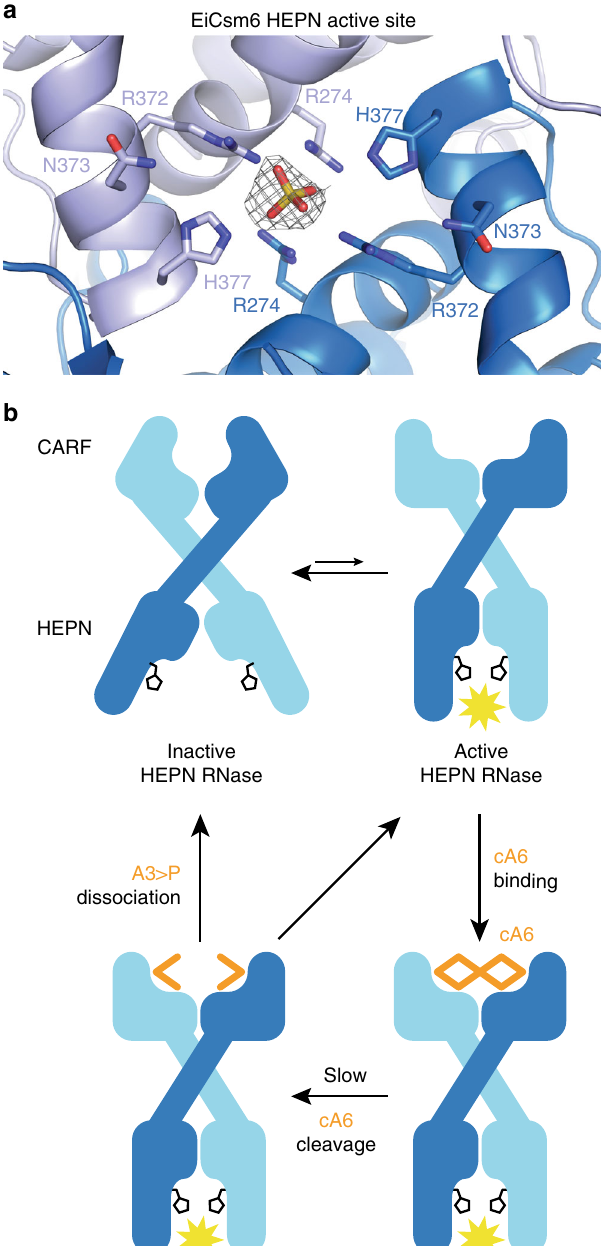
Fig. 4 Model of cA6-mediated allosteric activation mechanism of Csm6 RNases. a Zoom-in view of the HEPN domain ribonuclease active site in EiCsm6. The conserved R372, N373, H377 residues of the HEPN catalytic motif, and additionally R274, are represented as sticks. Electron density, interpreted as a sulfate ion (depicted as 2m F O – D F C composite omit map, contoured at 1.0 σ and displayed within a radius of 2.2 Å), is located within hydrogen bonding distance of H377, likely mimicking the scissile phosphate group of an RNA substrate. b Schematic model of the cA6-mediated allosteric activation mechanism of Csm6 Methods Protein expression and puri fi cation . The gene sequence of EiCsm6 was ampli fi ed from genomic DNA ( Enterococcus italicus DSM-15952) by PCR and cloned into a 1B vector (Addgene 29653) using ligation-independent cloning resulting in con- structs carrying an N-terminal hexahistidine tag followed by a tobacco etch virus (TEV) protease cleavage site. Point mutations were introduced by inverse PCR and veri fi ed by DNA sequencing. EiCsm6 and its mutants were puri fi ed similarly as